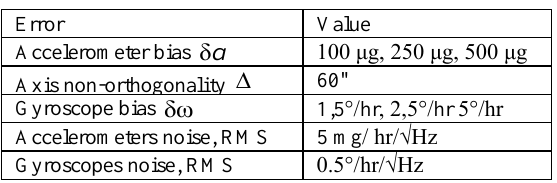
Figure 4. Complicated curve The movement of UAV has taken uniform, with a